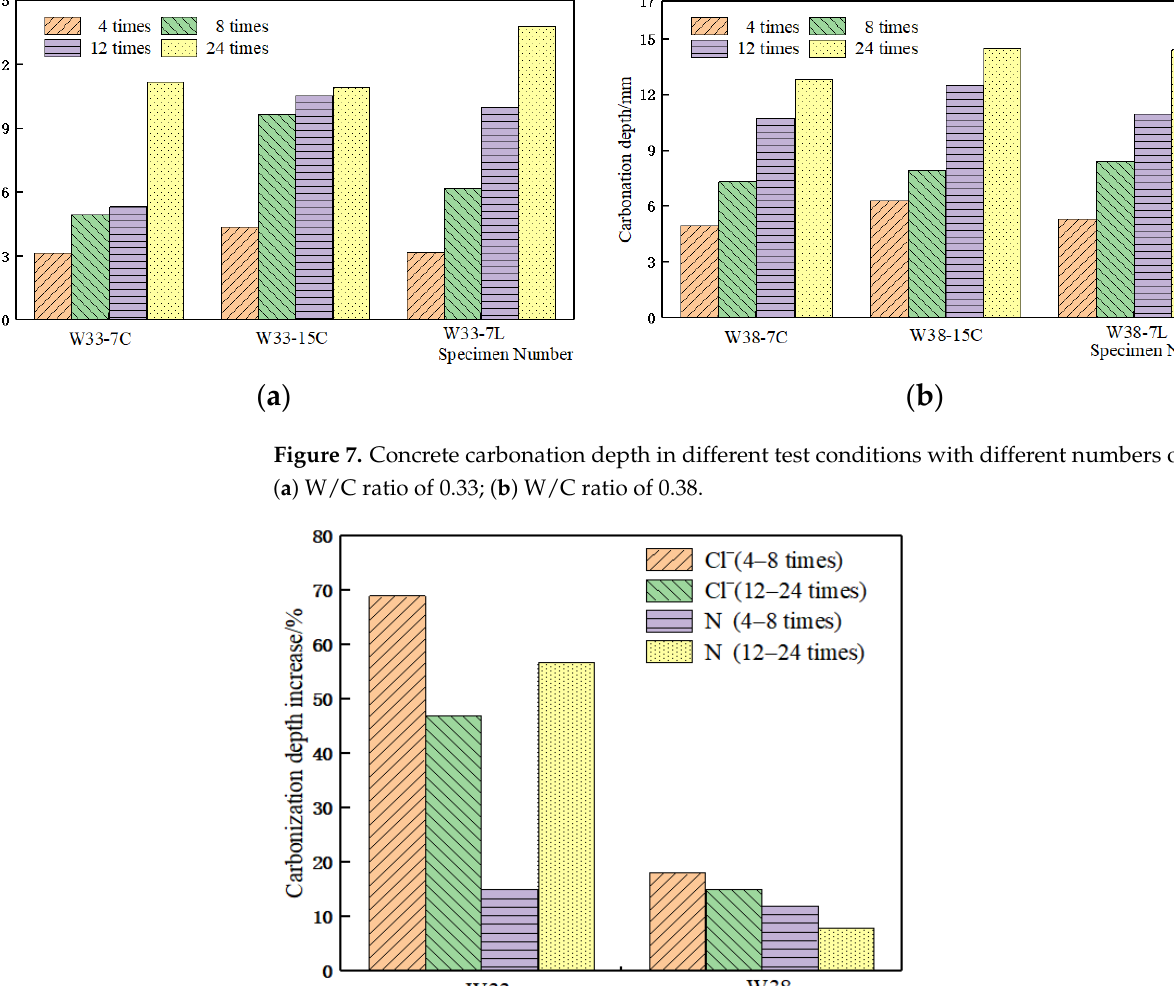
Figure 8. Effects of tensile stress and Cl − on carbonation.